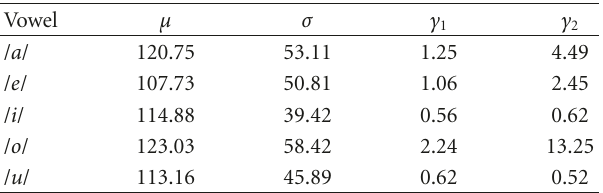
) values of the vowel length in the reference 2